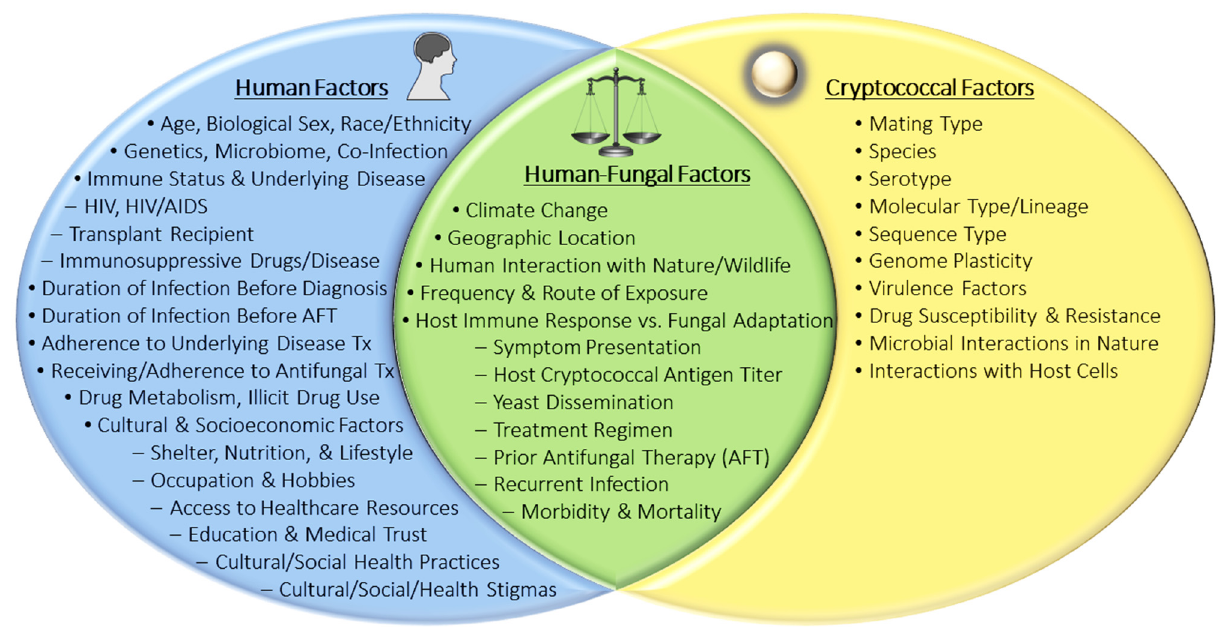
Figure 1. Factors that Contribute to Cryptococcosis Infection and Outcome. Abbreviations: Antifungal Therapy (AFT), Treatment (Tx).